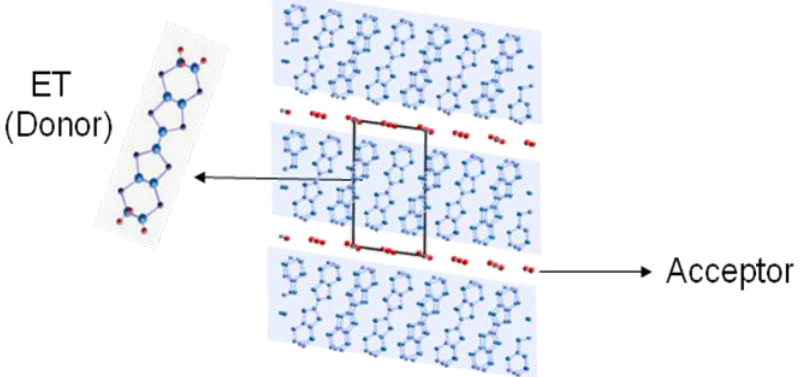
X consisting of donor (ET) layers and acceptor layers. 2